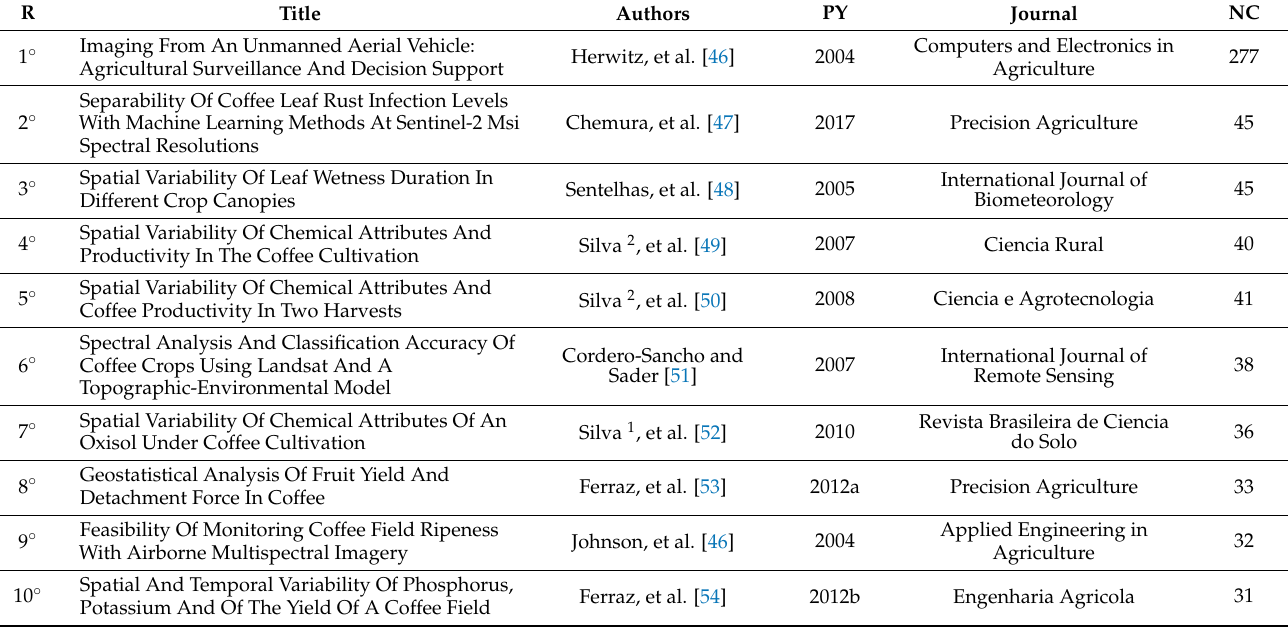
Table 1. Top 20 publications scientific on precision coffee growing from 2000 to 2021/1st sem, ranked by citation number.